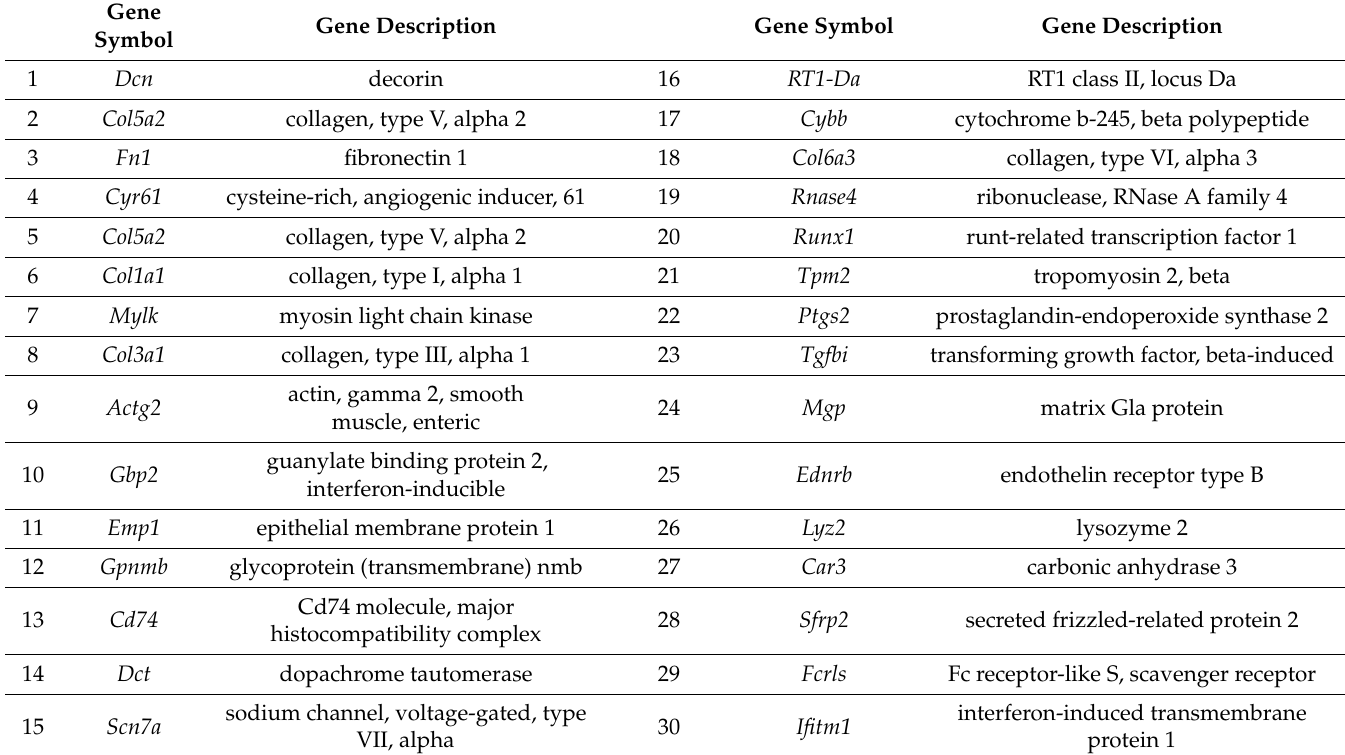
Table 1. Lists of top 30 genes which were > 2.0 times up-regulated at 1 W and 2 W after ECLE.